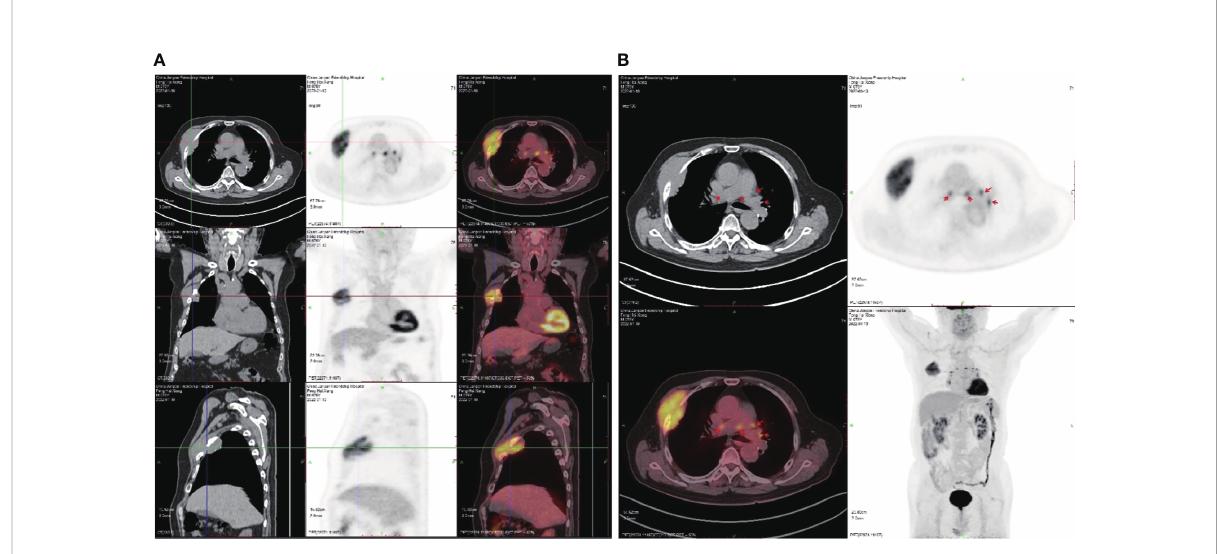
FIGURE 4 Positron emission tomography (PET) CT scans. (A) The tumor in frontal, lateral, and transverse section. (B) Multiple lymph nodes showing fl uorodeoxyglucose uptake in the mediastinum and hilum (SUVmax